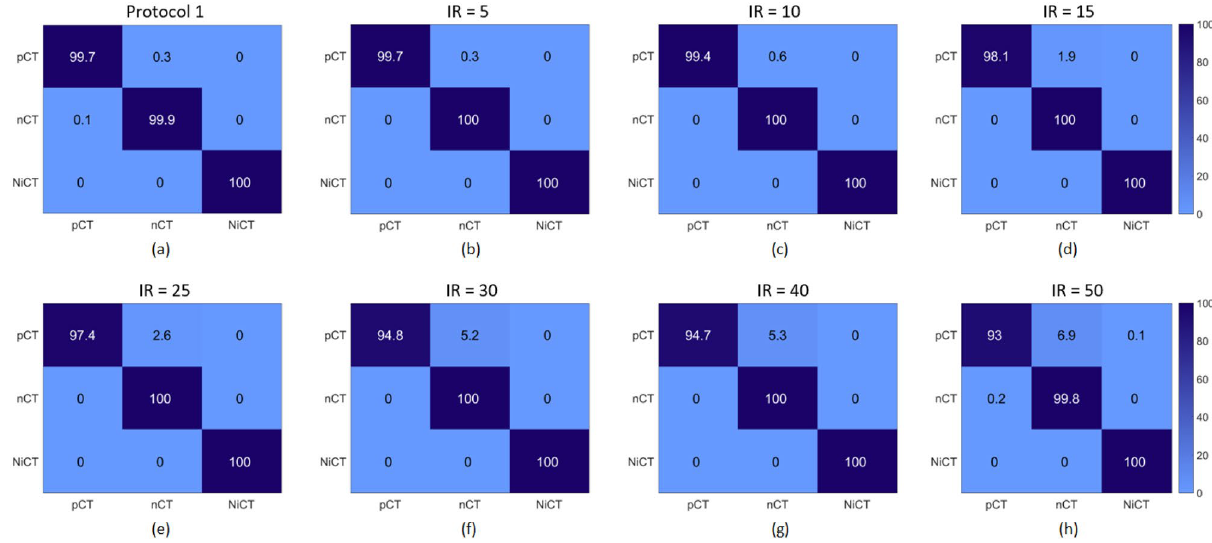
Figure 4. The confusion matrices of our RegCS.CapsDenseNet method. ( a ) with the first protocol. ( b – h ) the second protocol with different imbalance ratios (IR) = 5, 10, 15, 25, 30, 40, and 50, respectively. Method Val. Accuracy (%) Precision (%) Recall/Sens (%) Spec (%)